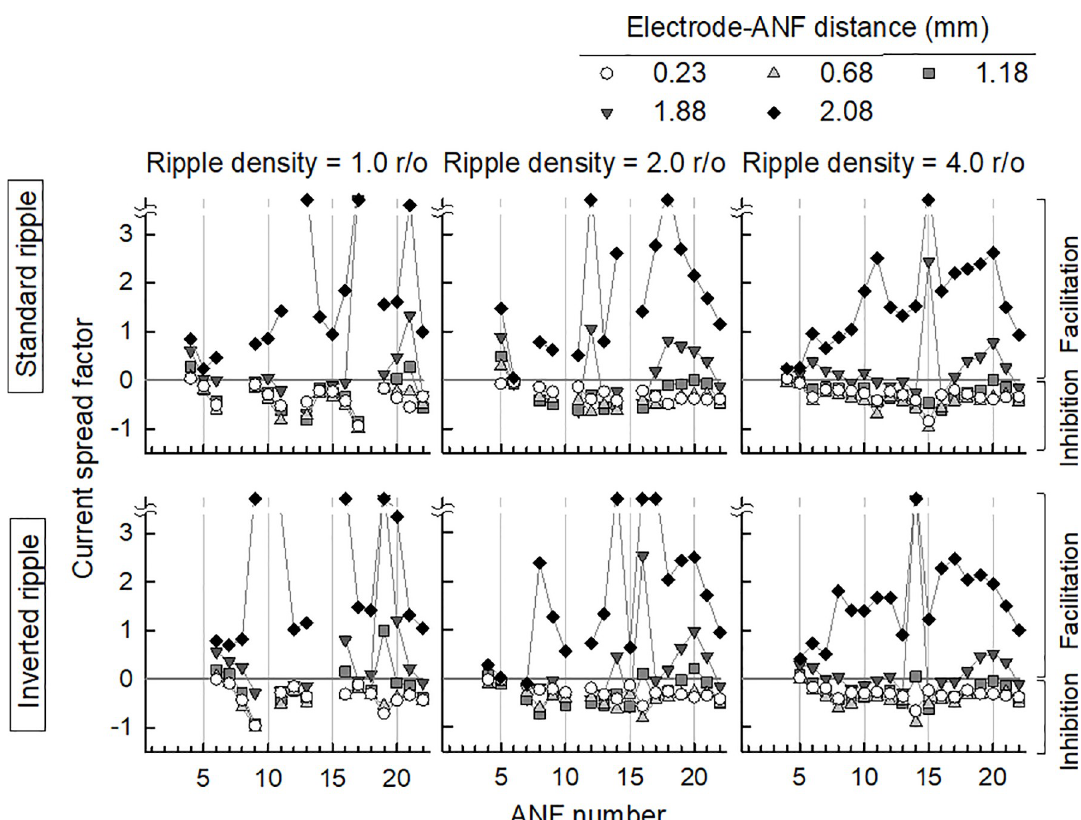
Fig 7. Current spread factors for three ripple densities and five electrode–ANF distances. The upper and bottom panels are respectively for standard and inverted ripple noises, while the left, middle, and right columns are for ripple densities of 1.0, 2.0, and 4.0 r/o, respectively. The gray line, which is the current spread factor of zero in each graph, indicates no effect of the current spread. A positive current spread factor indicates that a pulse delivered from a neighboring channel facilitates the excitation of the neural response, whereas a negative current spread factor indicates inhibition of the neural response. For an electrode–ANF distance of 2.08 mm, current spread factors above 3.5 are equally